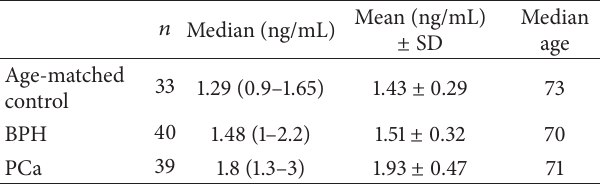
Table 1: Plasma CXCL12 concentrations in the 3 groups